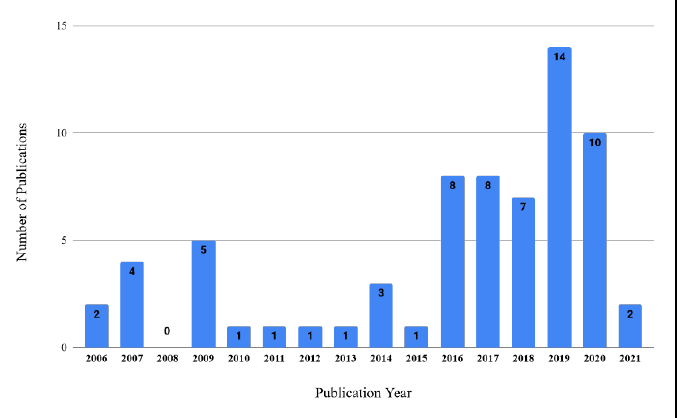
Figure 4. Distribution of papers by publication